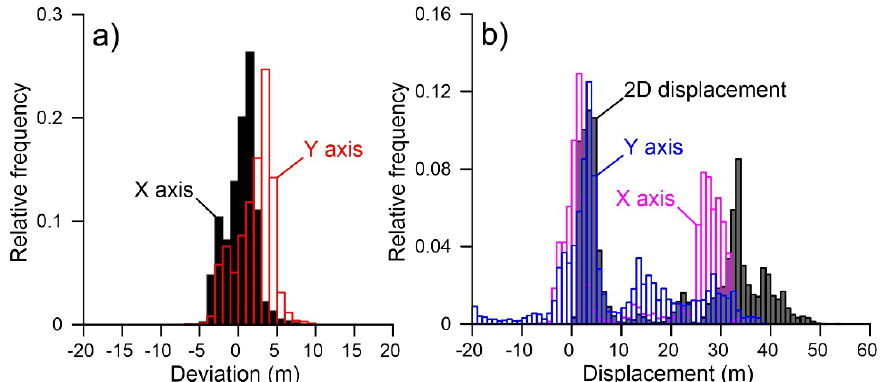
Figure 8. Miage debris-covered glacier and surrounding slopes. ( a ) Distribution of deviation in displacement estimation as derived by feature tracking in non-moving zones. ( b ) Distribution of displacement components and 2D total displacement as estimated by feature tracking within both the moving and non-moving zones. Remote Sens. 2020 , 12 , x FOR PEER REVIEW 11 of 14